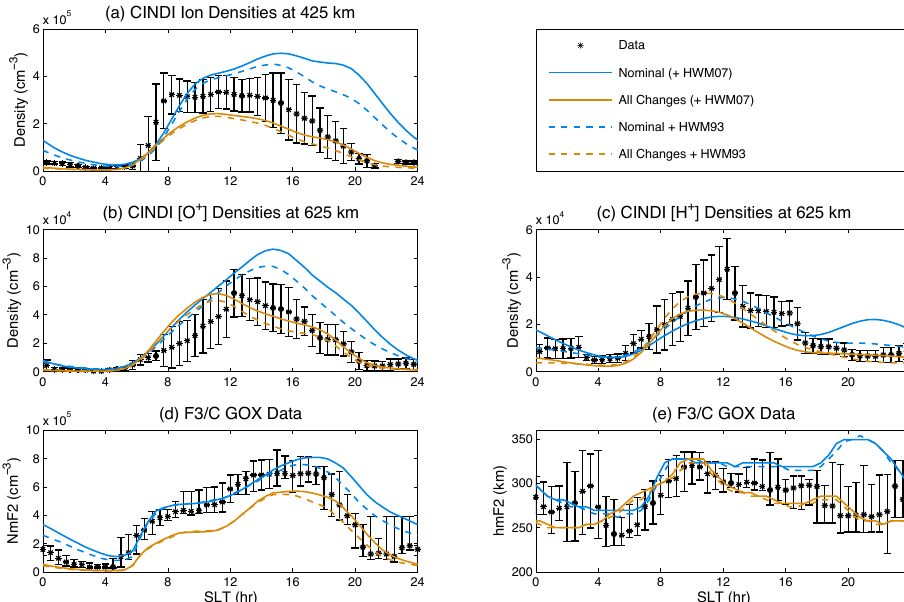
Fig. 10. A sensitivity study for the neutral winds compared to the five metrics used above in Figures 4-8. The solids lines indicate simulations using the HWM-07 model and are identical to the respective lines in the preceding figures. The dashed lines use the HWM-93 model to demonstrate the sensitivity to the wind morphologies shown in Figure 9.